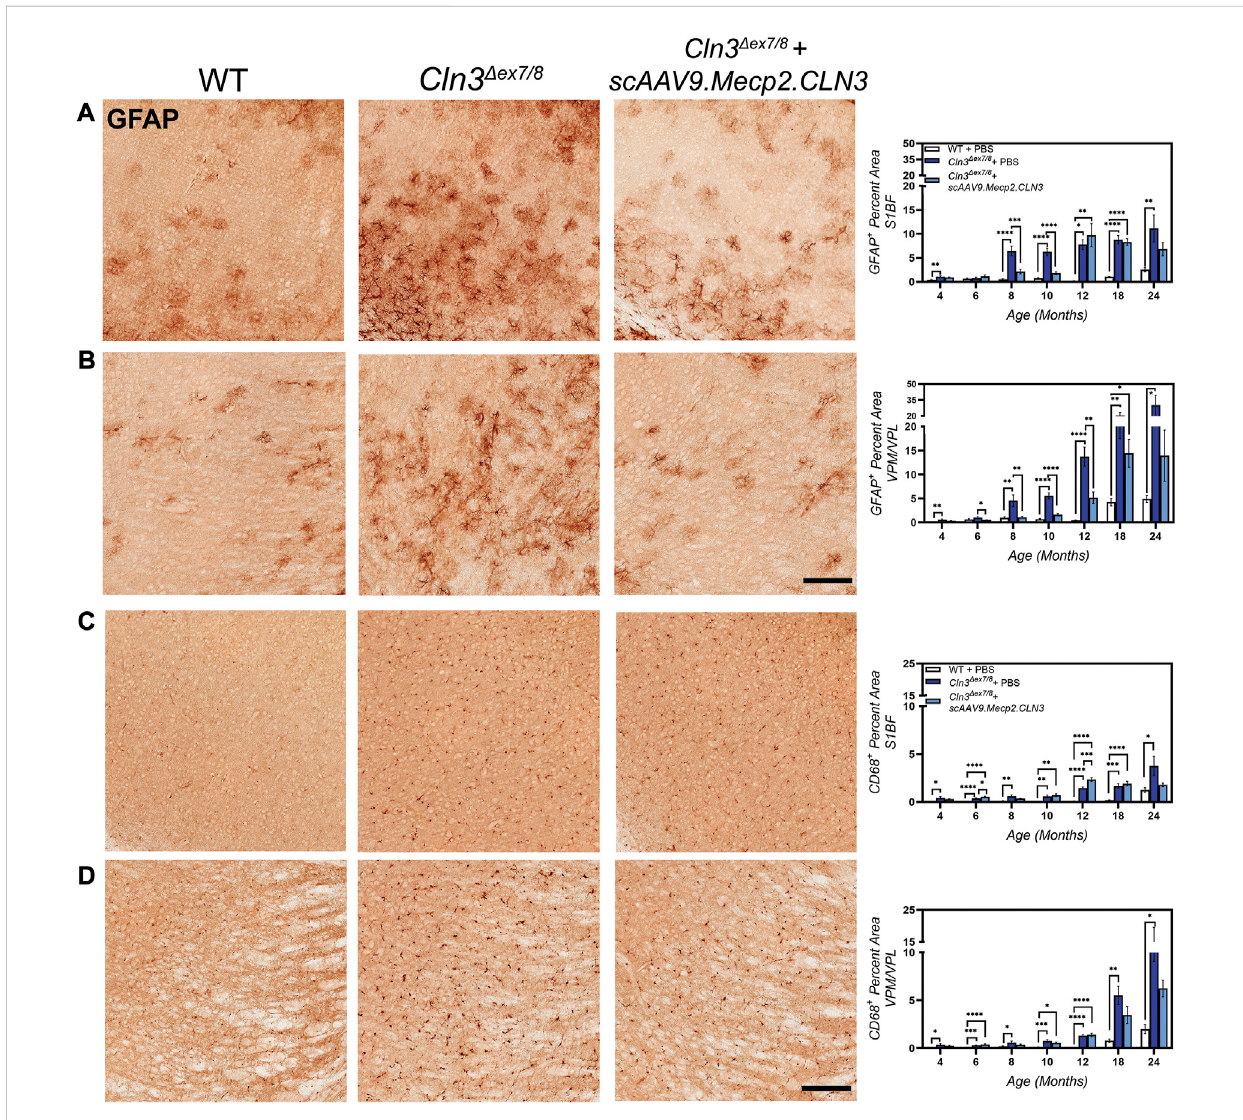
FIGURE 5 scAAV9.Mecp2.CLN3 reduces glial activation in Cln3 Δ ex7/8 mice. Neonatal administration of AAV9 reduces astrocyte activation (GFAP immunoreactivity) at several time points in the S1BF (A) and VPM/VPL (B) of Cln3 Δ ex7/8 mice. AAV9 also reduces microglial activation (CD68 immunoreactivity) in the S1BF (C) and VPM/VPL (D) of Cln3 Δ ex7/8 mice at several time points. Scale Bars = 25 µm, images presented are